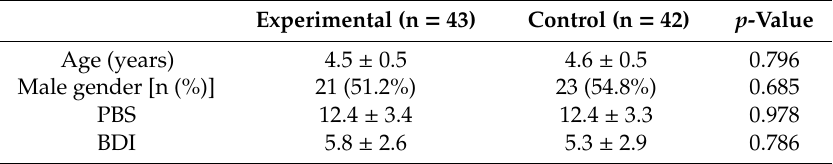
Figure 1. Flow chart of participants through the trial. (PBS: Pediatric balance scale, BAT: Battelle Figure 1. F low chart of participants through the trial . (PBS: Pediatric balance scale, BAT: Battelle developmental inventory). developmental inventory) . Table 1. Baseline demographics for both Table 1. Baseline demographics for both groups.